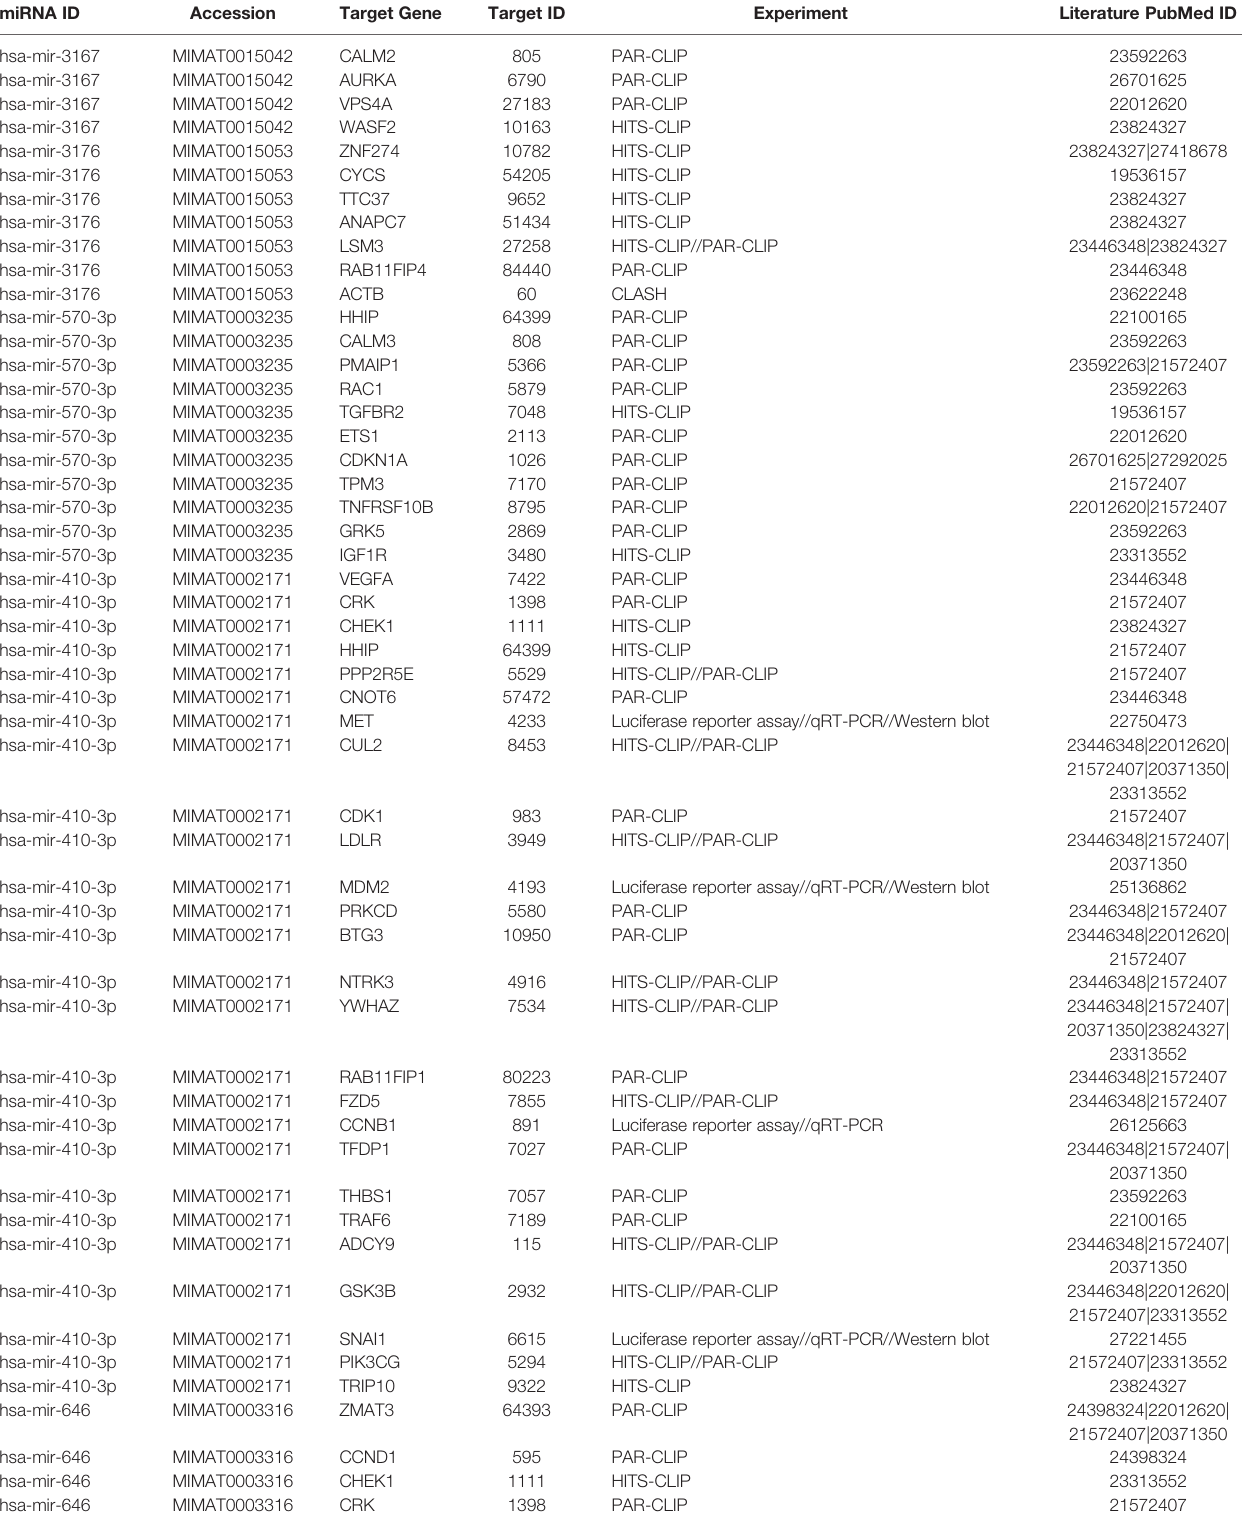
TABLE 1 | Upregulated miRNAS and target genes in response to